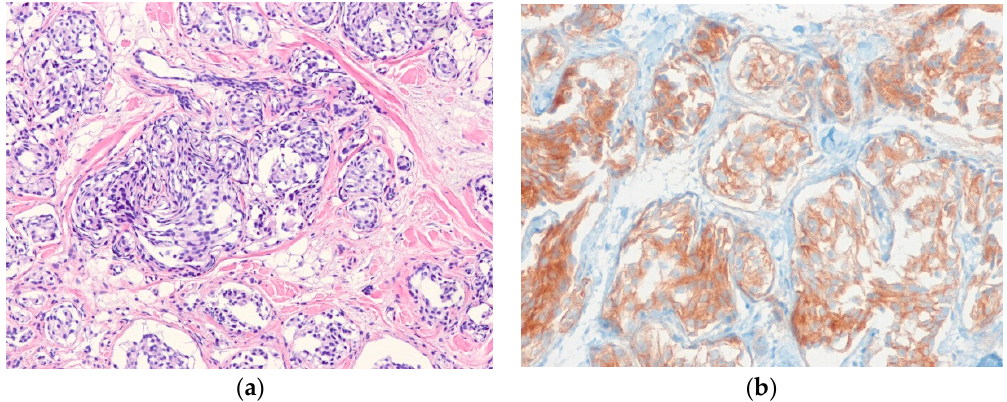
Figure 5. Ectopic meningioma. ( a ) The tumor cells are arranged in whorling or nesting pattern, with fibromyxoid stroma; ( b ) The tumor cells are positive for EMA (H&E stain, original magnification 100× ( a ); EMA immunostain, original magnification 200× ( b )). ( a ); EMA immunostain, original magnification 200 × ( b